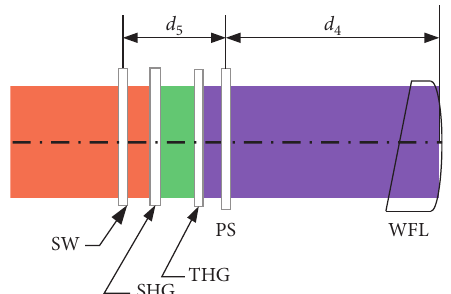
Figure 6: The model of first-order stray light.